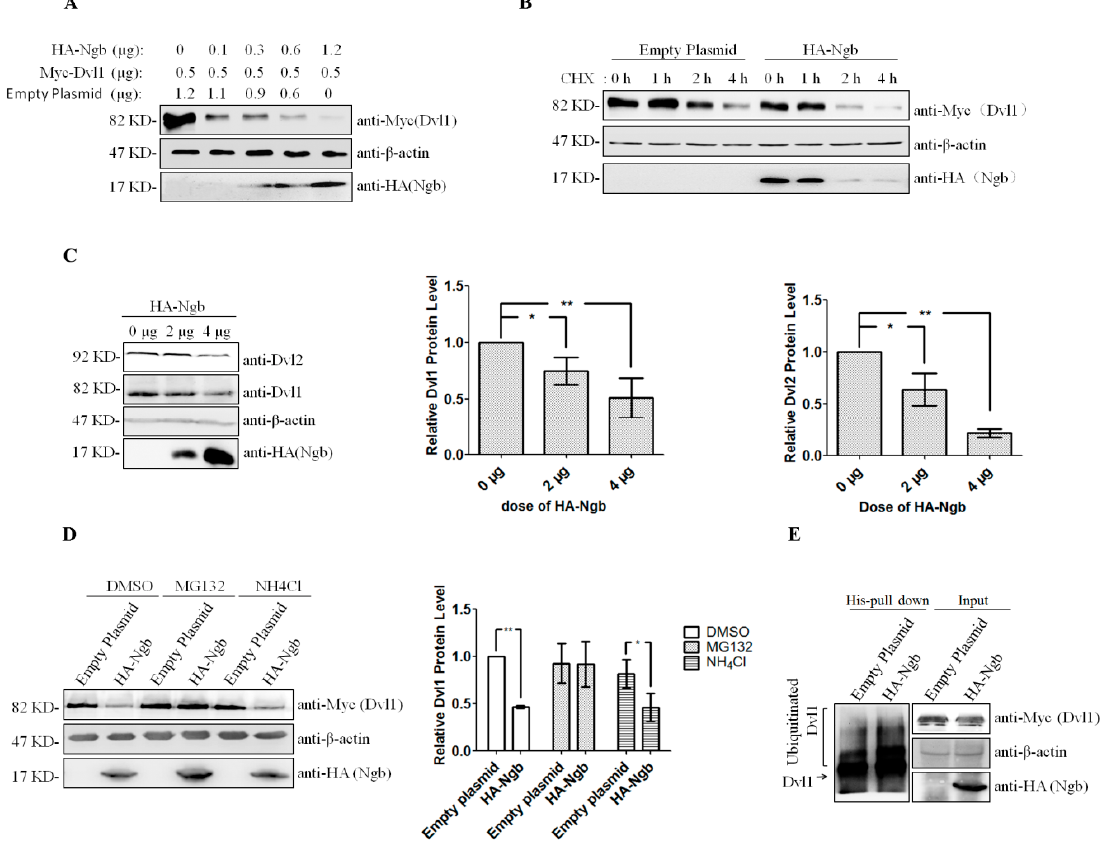
Figure 2. Ngb promotes the proteasomal degradation of Dvl1. ( A ) SK-N-SH cells were seeded in 6-well plate and transfected with plasmids as described. Cells were harvested after 24 h post-transfection. ( B ) SK-N-SH cells were cultured in 6 cm plate and transfected with the increased amount of HA-Ngb as described. Western blot was used to detect the expression of Dvl1 and Dvl2. densitometric analysis of western blot showed the effect of Ngb on Dvl1 and Dvl2 protein levels. β -actin served as equal loading controls. (Mean ± SD). n = 3, * p < 0.05, ** p < 0.01 versus cells transfected with empty plasmid. ( C ) 2 μ g HA-Ngb or empty plasmid (pCMV-HA) was co-transfected with 0.5 μ g Myc-Dvl1. After 12 h of post-transfection, cells were treated with CHX for 0, 1, 2, and 4 h. ( D ) Cells were treated with DMSO, MG132, or NH 4 Cl for 8 h. Densitometric analysis of western blot showed the effect of MG132 and NH 4 Cl on the Ngb-induced degradation of Dvl1 β -actin served as equal loading controls. (Mean ± SD). n = 3, * p < 0.05, ** p < 0.01 versus cells transfected with controls as described. ( E ) His-Ub and Myc-Dvl1 were co-transfected with HA-Ngb or empty plasmid (pCMV-HA) into SK-N-SH cells. Then the His-ubiquitinated proteins were isolated from cell extracts using NTA agarose. Western blot was used to detect ubiquitinated Dvl1. To determine whether the decreased Dvl1 level resulted from protein degradation, SK-N-SH cells were co-transfected with Myc-Dvl1 plasmid and HA-Ngb plasmid or empty plasmid (pCMV-